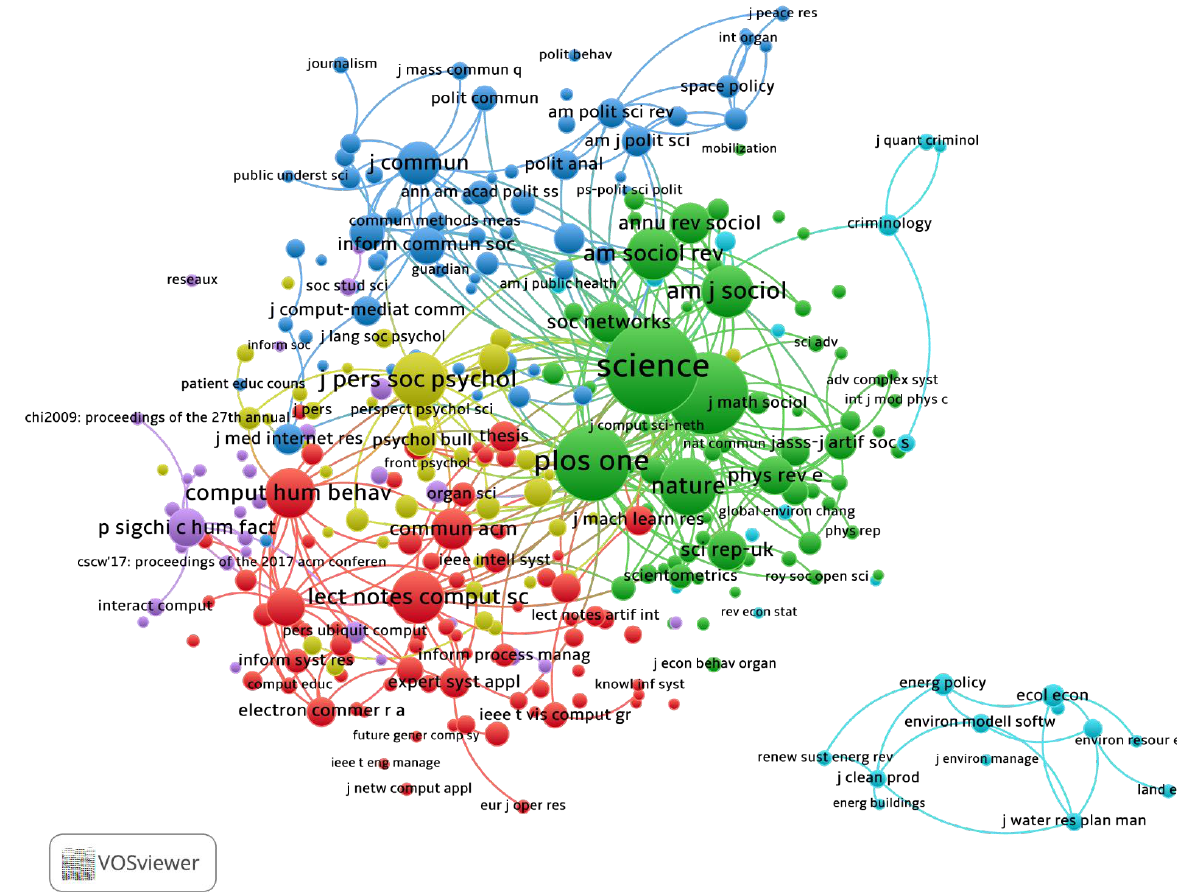
Figure 5. Knowledge base environment of CSS, based on WoS CSS dataset. Existing clusters represented by different colours and the division is not fortuitous.